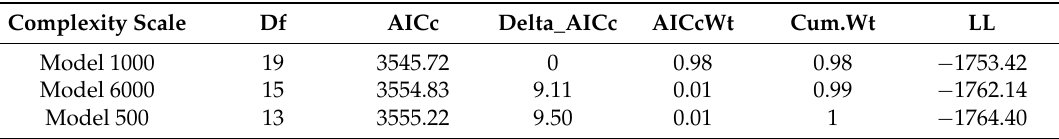
Table 4. Comparison of the three simplest models for diversity index. Df: degrees of freedom of the model; AICc: corrected Akaiki information criterion; Delta AICc: difference in AICc between the model and the model with the smallest AICc; AICcWt: model weight according to delta AICc; Cum. Wt: cumulative model weights; LL: Log